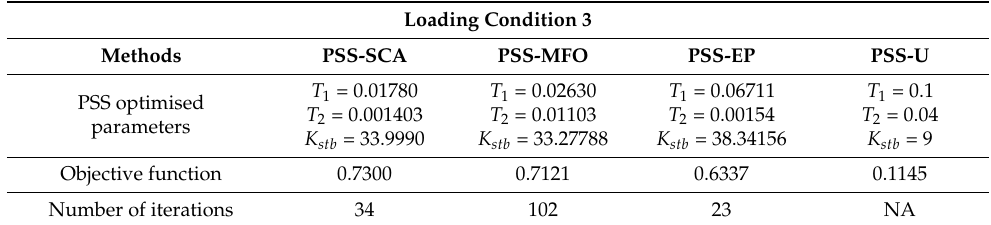
Table 9. Comparison of the PSS optimised parameters, eigenvalues, damping factor and damping ratio for loading condition 3 of the